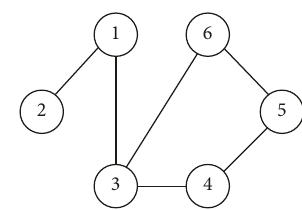
Figure 1: The fixed topology of Example 1.